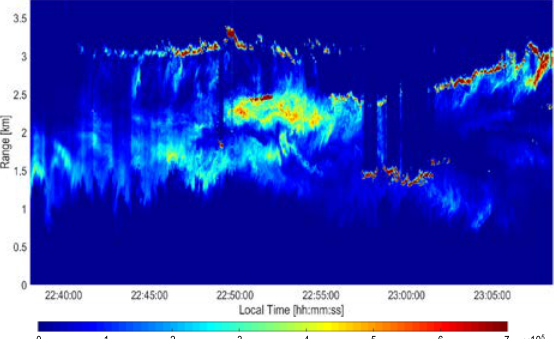
Figure 4. False color diagram for near–field record of cumulus clouds structure. Colors represent the 2- µ m rang corrected signal strength.